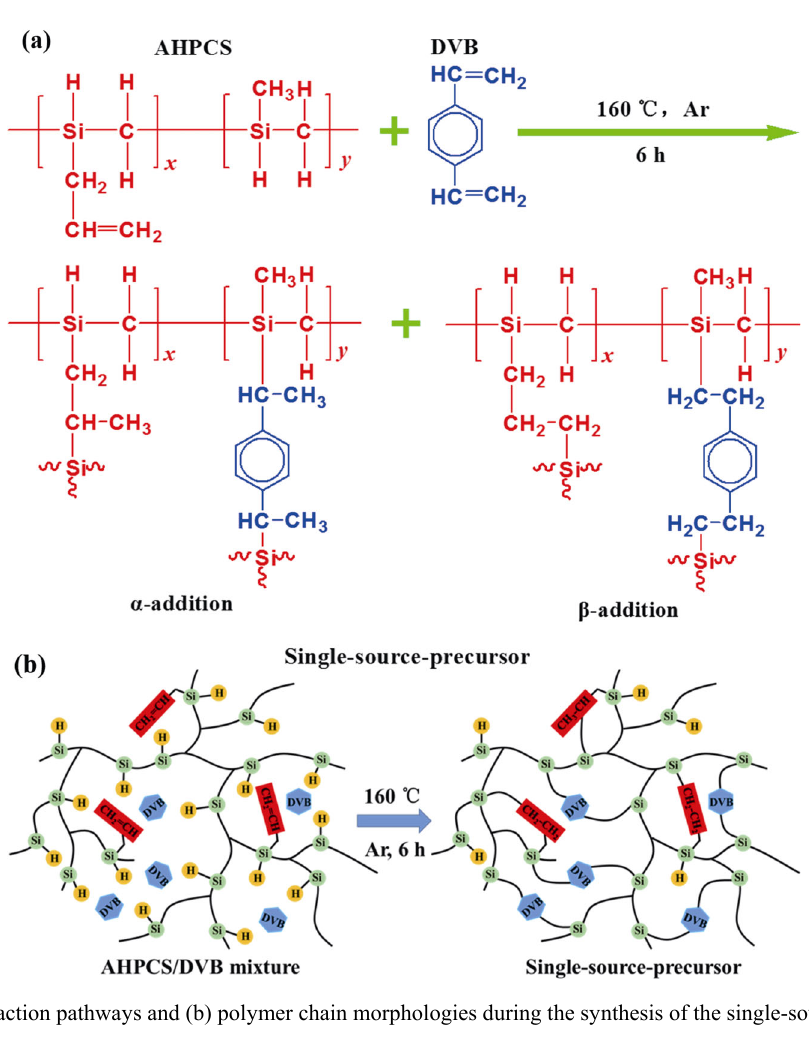
Fig. 3 (a) Reaction pathways and (b) polymer chain morphologies during the synthesis of the single-source-precursor.